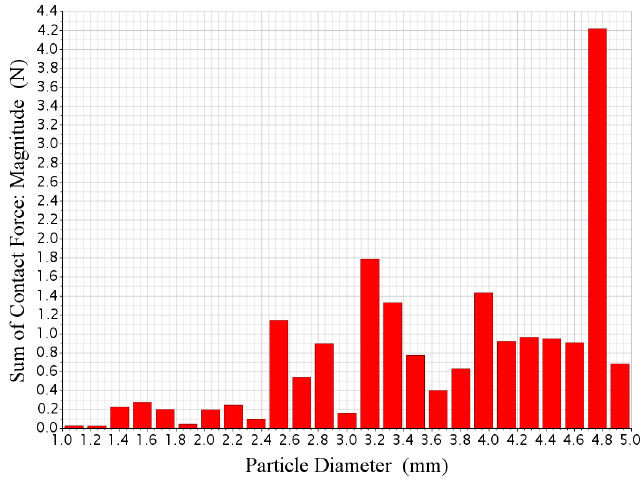
Figure 9. Histogram of the particle size to contact force.